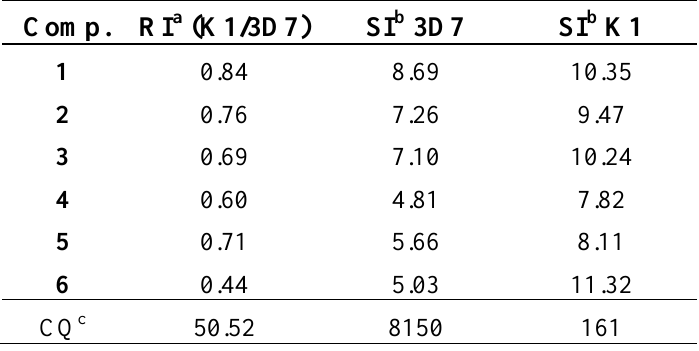
Table 2. Resistance index (RI) and Selectivity indexes (SI)